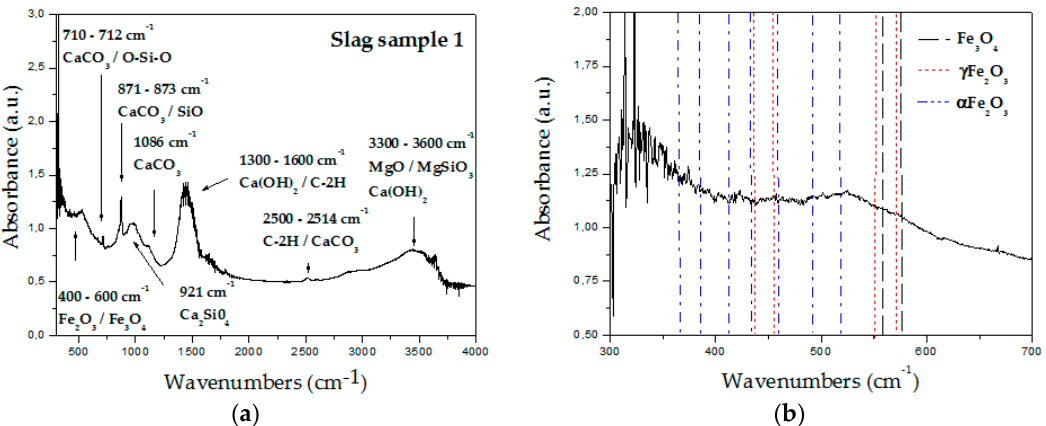
Figure 2. FTIR spectra of the: ( a ) slag sample 1 for wavenumbers ranging from 300 to 4000 cm − 1 ; ( b ) slag sample 1 for wavenumbers ranging from 300 to 700 cm − 1